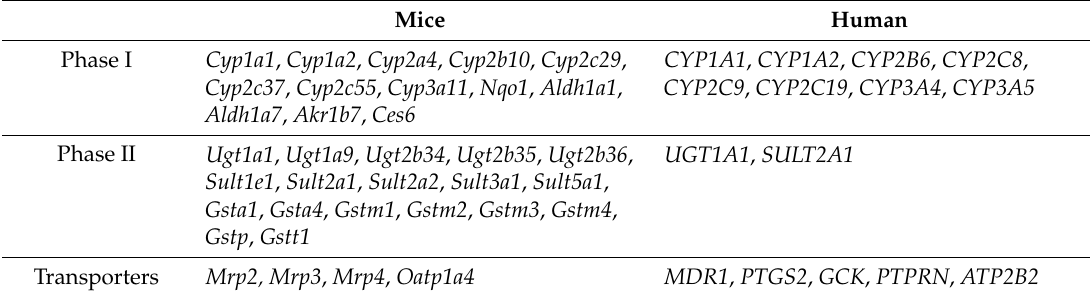
Table 1. Constitutive Androstane Receptor (CAR) target genes involved in detoxification processes